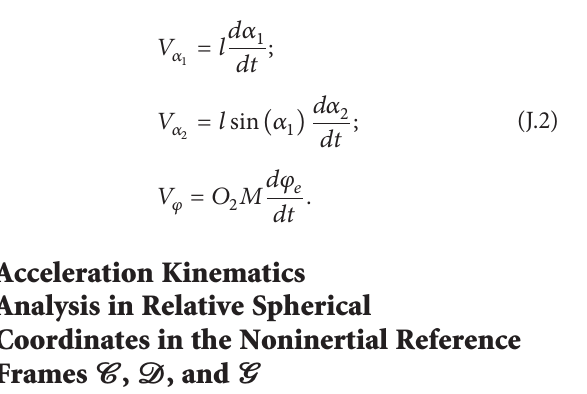
comoving reference frames C , D , and G have the following